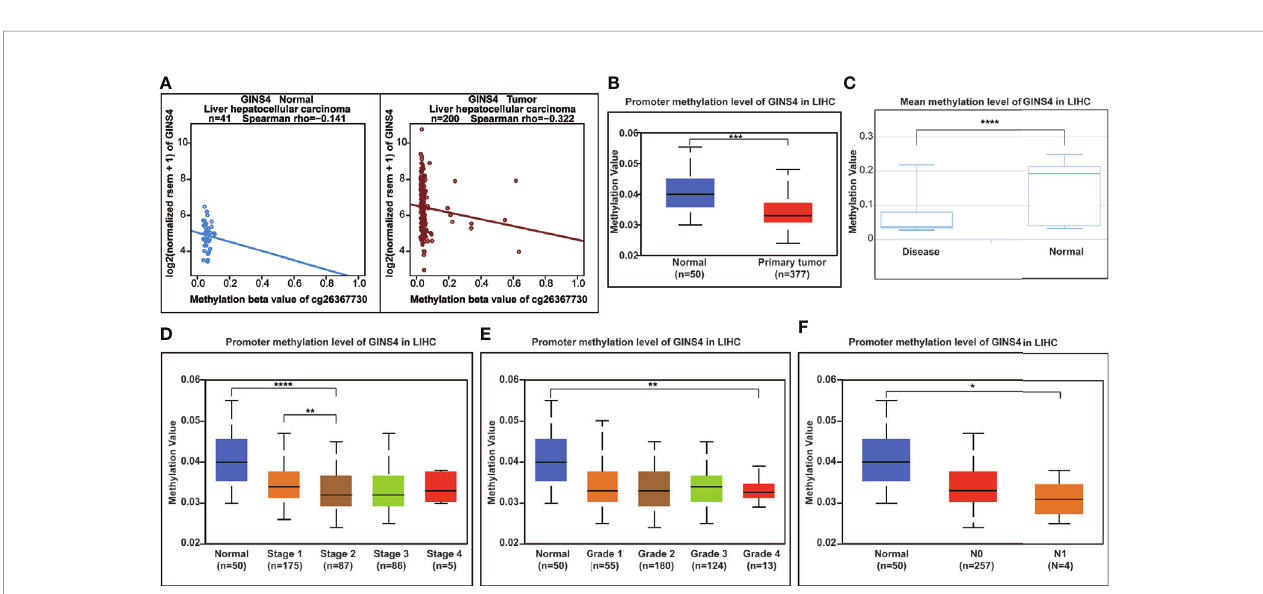
FIGURE 11 | The correlation between GINS4 methylation and clinical characteristics of HCC patients. (A) The association between GINS4 expression and its methylation level of cg26367730 methylation site in HCC samples and matched normal liver tissues from the Wanderer. Total GISN4 methylation in HCC samples was signi fi cantly lower compared with the normal liver samples evaluated by (B) UALCAN and (C) DiseaseMeth databases. The association between GINS4 methylation levels and (D) TNM stage, (E) histological grade, and (F) lymph node status of HCC patients downloaded from UALCAN